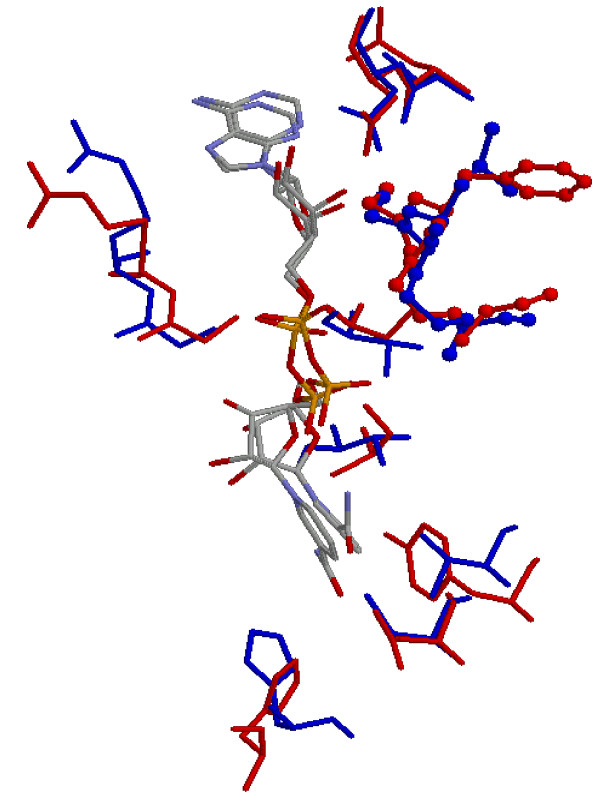
Superposition of matching amino acids (Case 3) between alcohol dehydrogenase (1hdx_1; blue) and glyceraldehyde-3-phosphate dehydrogenase (3dbv_3; red) after MCMC refinement (RMSD = 0.672; number of corresponding amino acids = 12; p-value = 3.68e-05). The matched dinucleotide binding motif is shown in ball-and-stick representation. Ligands are coloured in CPK colours.